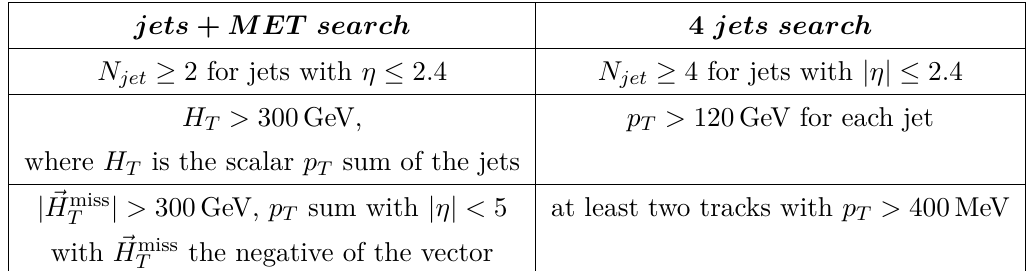
Table 1. Summary of the requirements for an event to count as signal for the jets plus MET search and the four jets